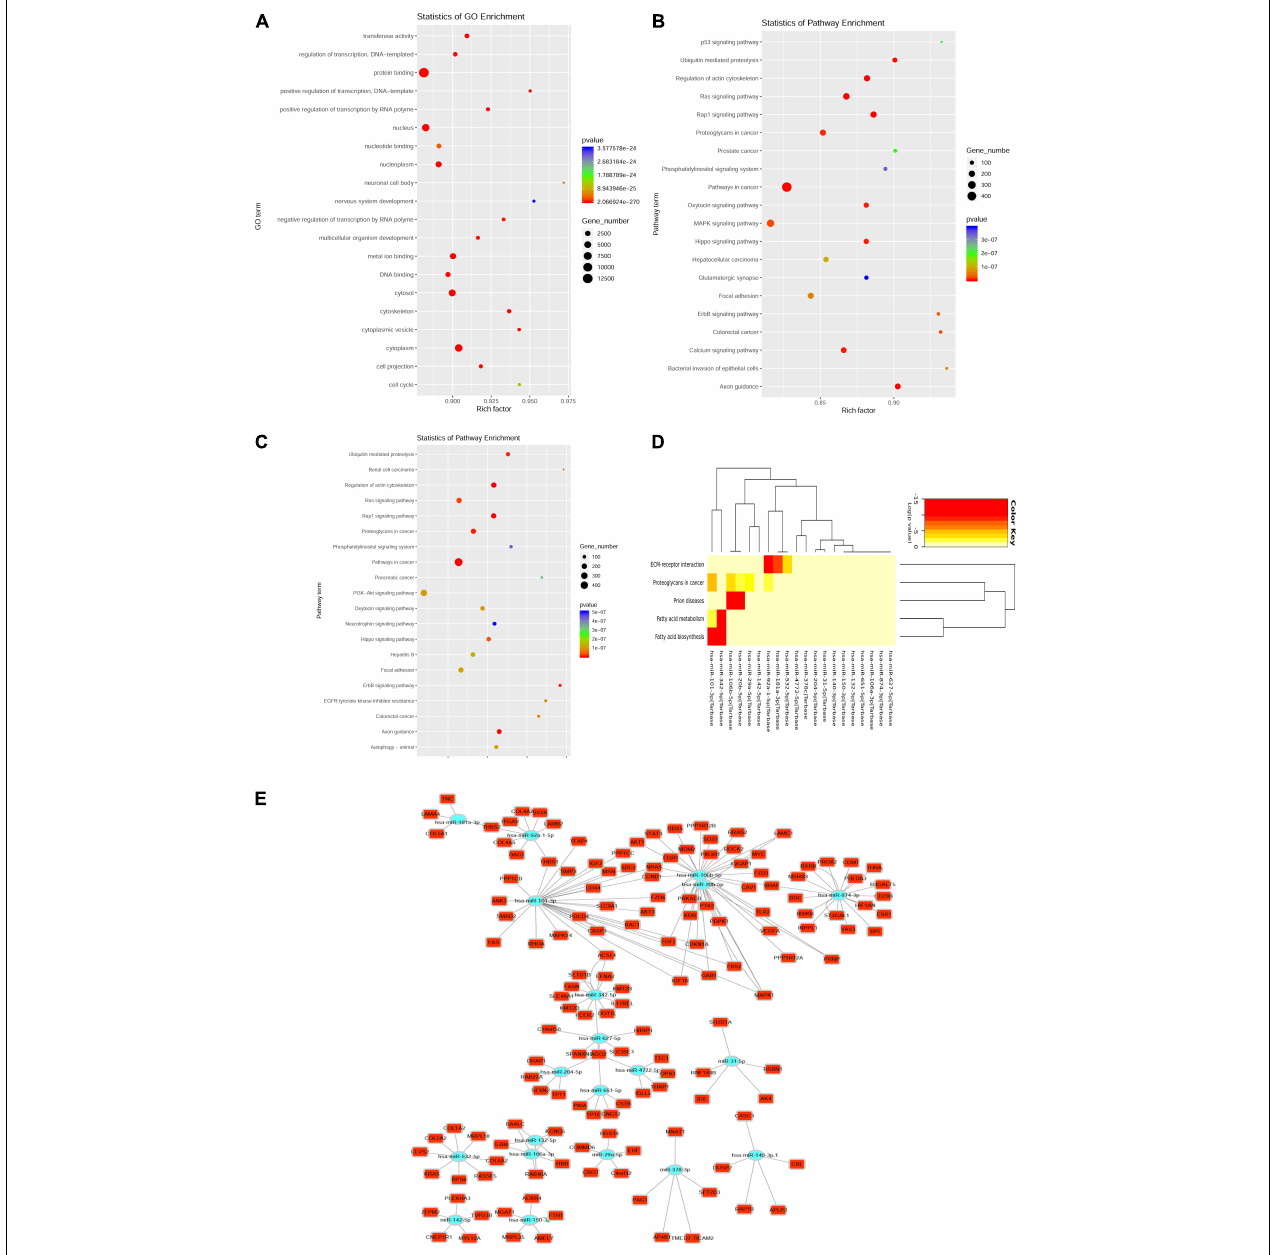
FIGURE 3 | Top 40 dysregulated miRNAs targeting messenger RNA (mRNA). (A) Enrichment of the Gene Ontology (GO) annotated mRNAs (dysregulated miRNAs targeting mRNA). (B,C) Enrichment of upregulated miRNAs targeting mRNAs in the Kyoto Encyclopedia of Genes and Genomes (KEGG) pathway (B) ; Enrichment of downregulated miRNAs targeting mRNAs in the KEGG pathway (C) . Y-axis label represents the pathway and X-axis label represents the rich factor. The greater the rich factor, the greater the degree of pathway enrichment. The size and color of the bubble represents the amount of differentially expressed genes enriched in the pathway and enrichment significance, respectively. (D) Heatmap of downregulated miRNA targeting the KEGG pathway clusters using miRPath v3 bioinformatics tools (top 20 downregulated miRNAs targeting mRNA). (E) The network indicating the top 20 downregulated miRNAs targeted